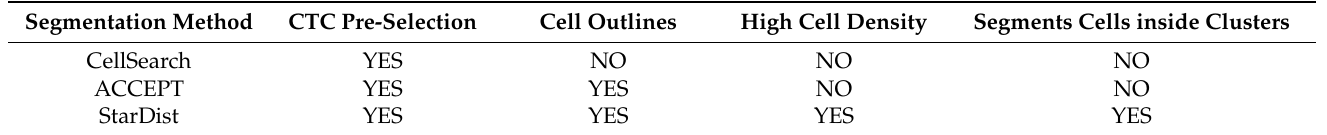
Figure 1. Four example images with the accompanying segmentations as performed by CellSearch, ACCEPT, and StarDist. The first column shows a false-color image in which the nuclear staining is colored blue (DAPI), the cytokeratin staining green (CK-PE), and CD45 staining red (CD45-APC). The second column shows the same image in black and white with the yellow rectangular CellSearch segmentation areas. In the third and fourth columns, the ACCEPT and StarDist segmentations are depicted as a separate color for each segmented event. StarDist clearly performs best in segmenting all single events separately, especially in areas containing a high cell density. Table 1. Suitability of CellSearch, ACCEPT, and StarDist for segmentation tasks. Overview of the suitability of the CellSearch, ACCEPT and StarDist for the pre-selection of likely CTC, identification of cell outlines, segmentation of cells in high-density samples, and ability to resolve cells that are part of a cluster.